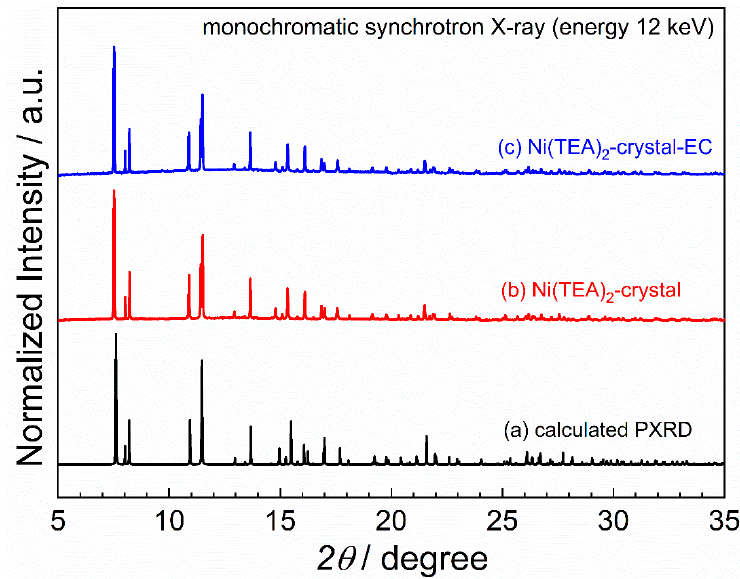
Figure 4. Fourier transformed infrared spectroscopy (FTIR) spectrum of the Ni-TEA complex.